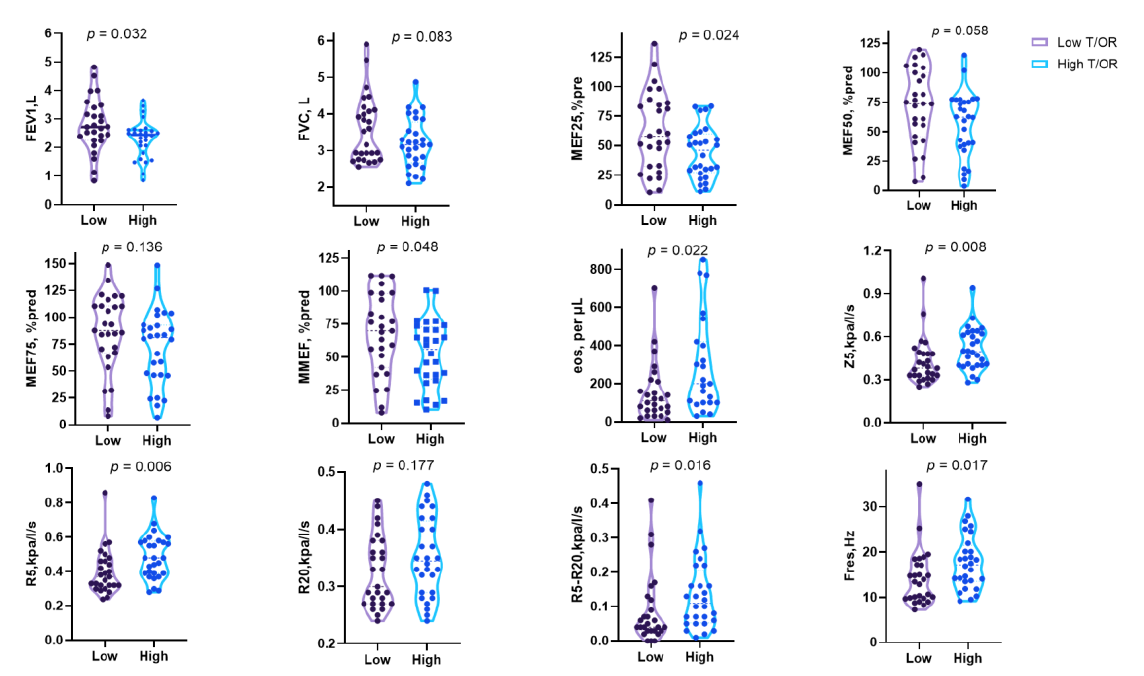
Figure 6. Spirometry and lung airway resistance parameters according to the airway wall thickness stratified by T/OR ratio. Data expressed as median and interquartile range.